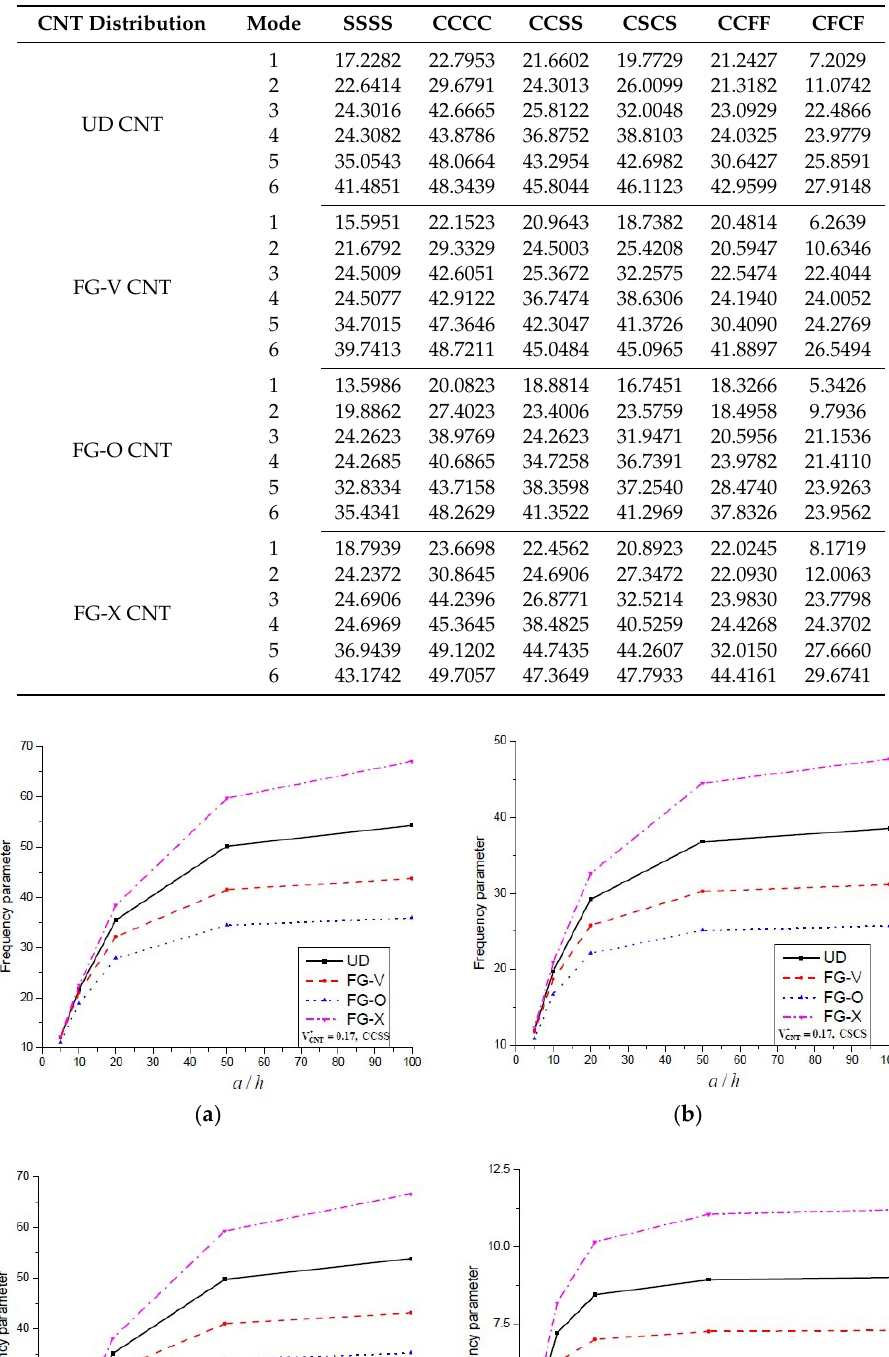
(cid:0) = 0.17, a / h = 10 (cid:1) . V ∗ CNT